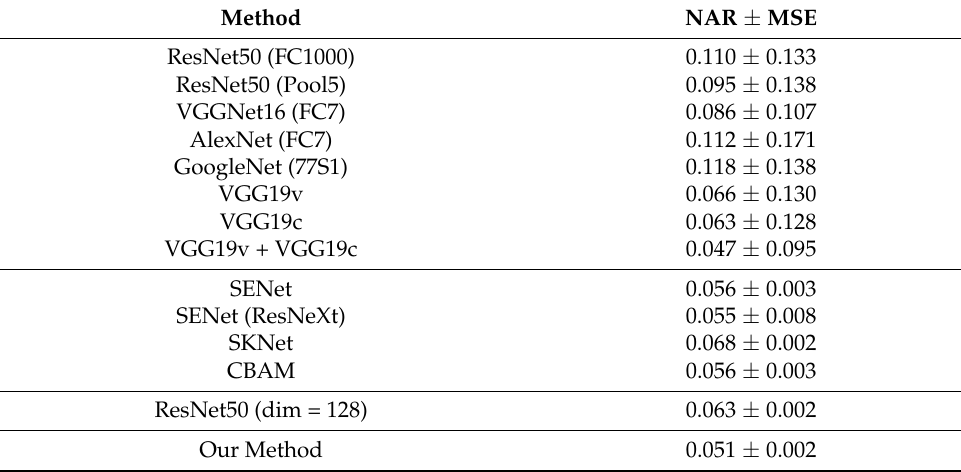
Table 2. Comparison with deep learning trademark retrieval